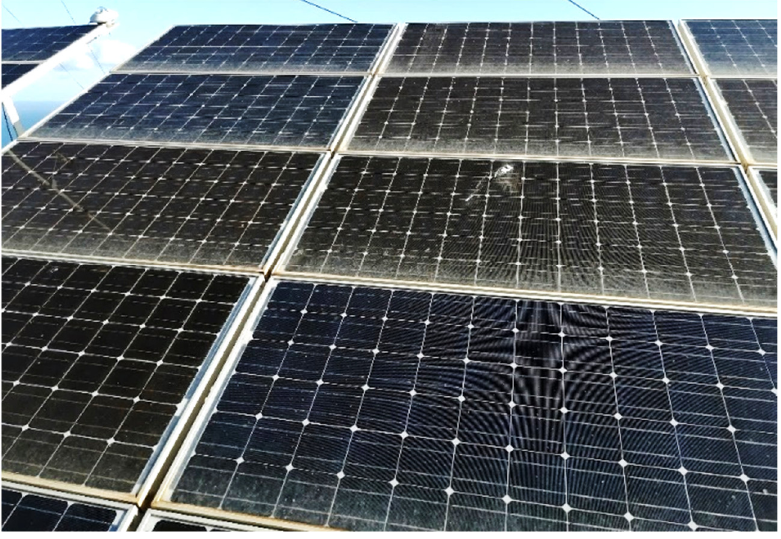
Figure 26. Dust accumulation and bird dropping on PV sub-array 1.